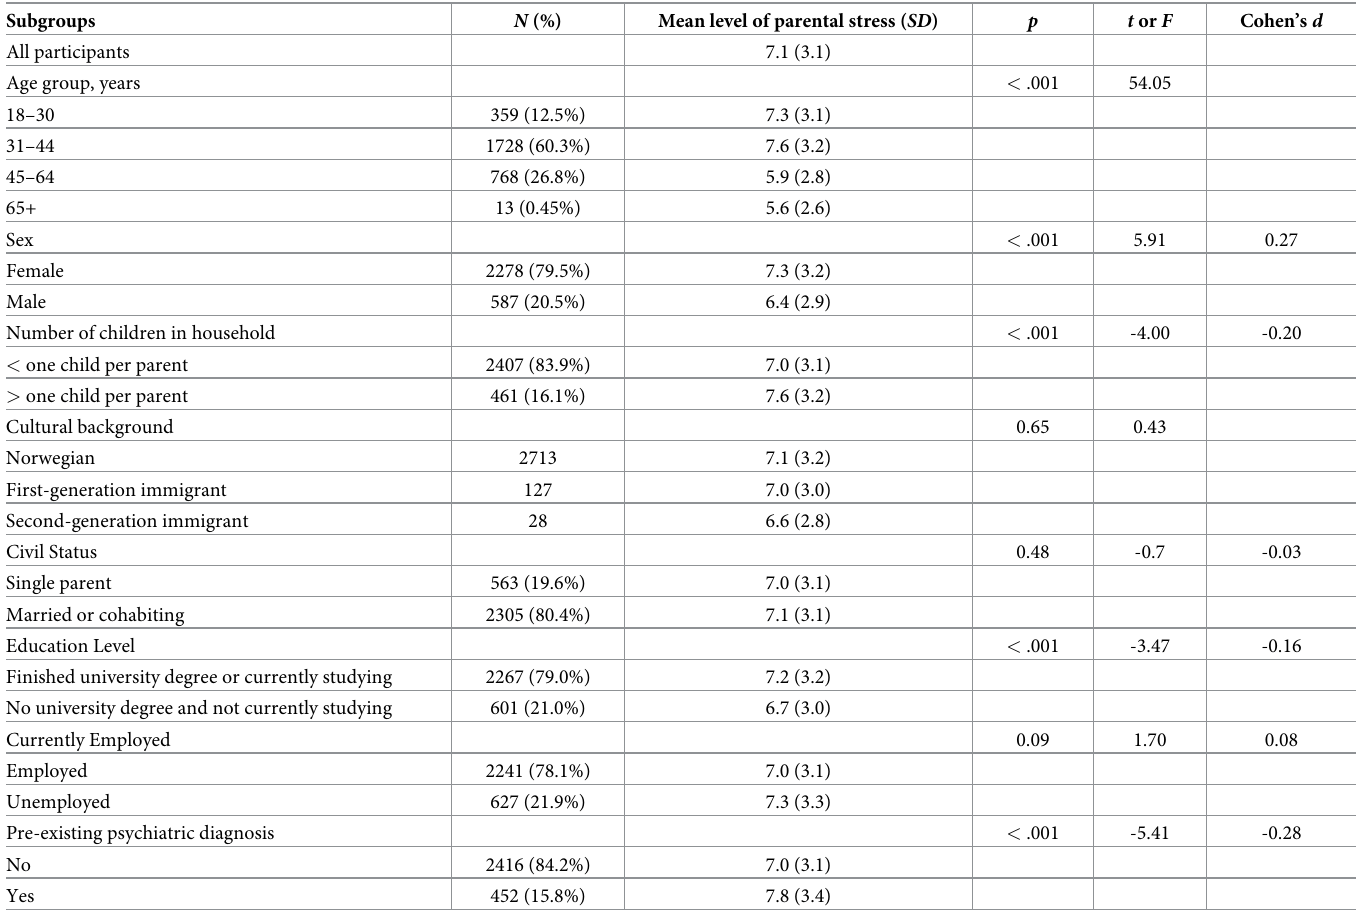
Table 2. Demographic information of the participants at T1 and mean level of parental stress in each